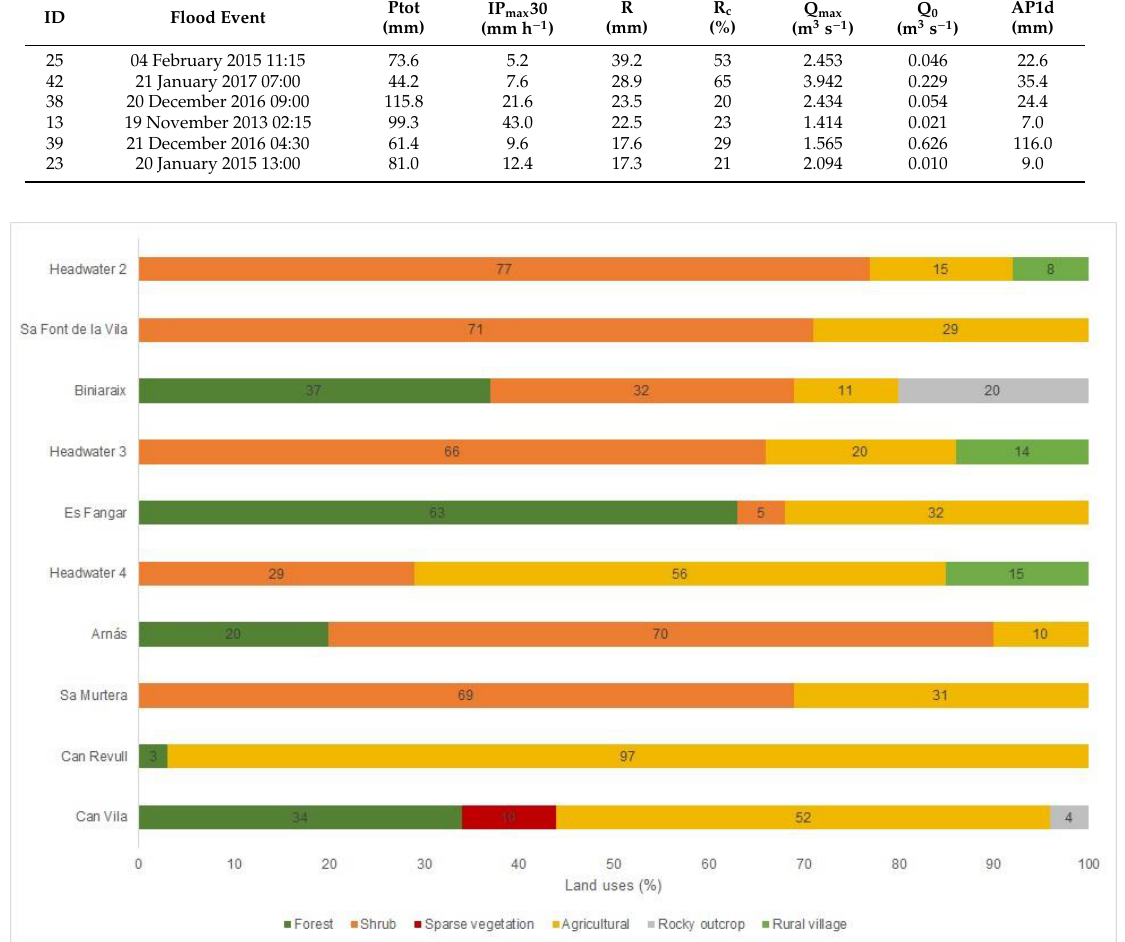
Figure A1. Land uses (%) for the 10 of 12 small Mediterranean-climate catchments selected for the rainfall-runoff relationship analysis. Guadalperalón and Parapuños catchments have not detailed land uses information.